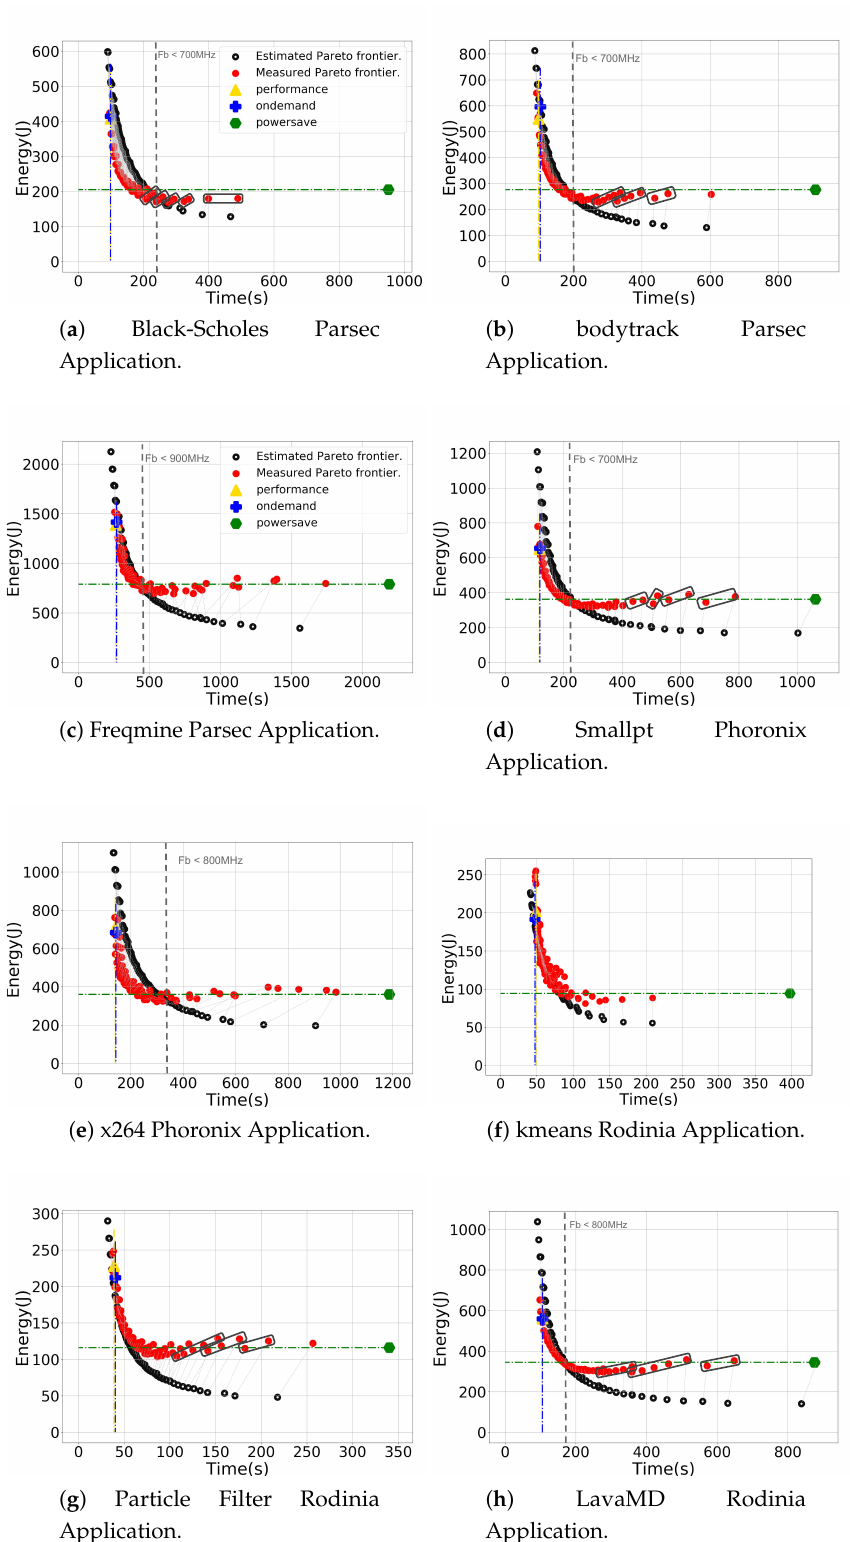
Figure 5. Estimated and measured Pareto frontier compared with the default governors removing all possible modeled